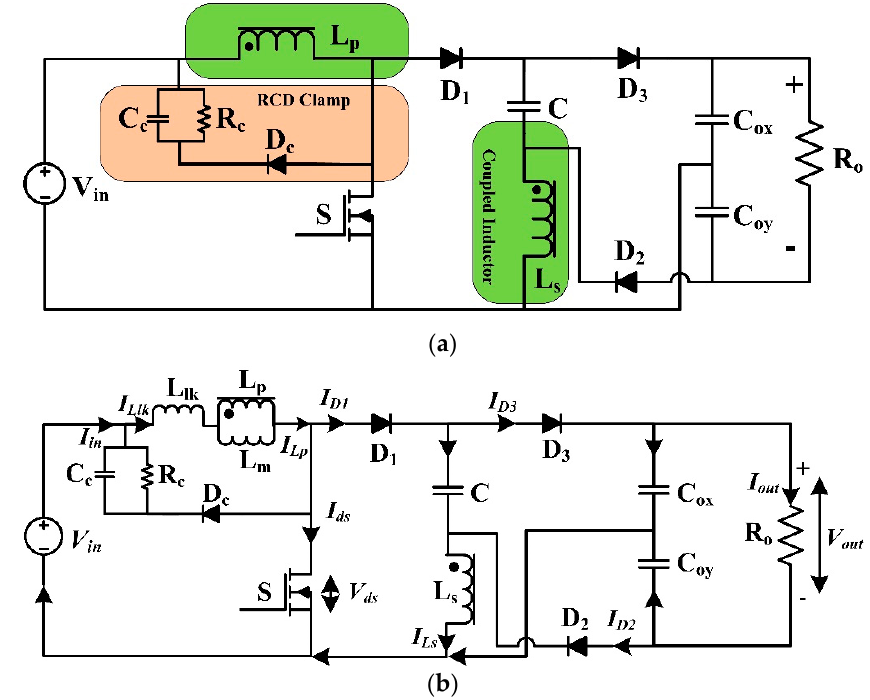
Figure 1. System configuration; ( a ) Circuit structure of the proposed converter, ( b ) Equivalent circuit of the proposed converter.